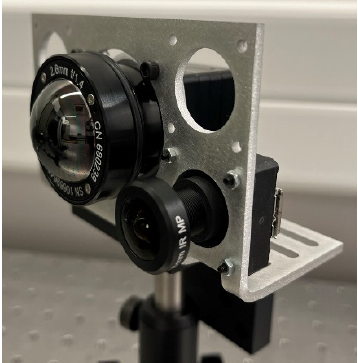
Figure 5. Laboratory test setup featuring the thermal channel and one of the visible and NIR imaging channels.